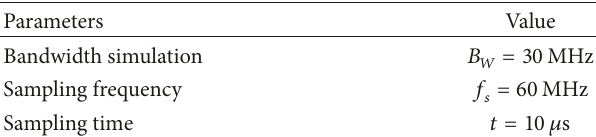
Figure 7: OMP multireconstruction.